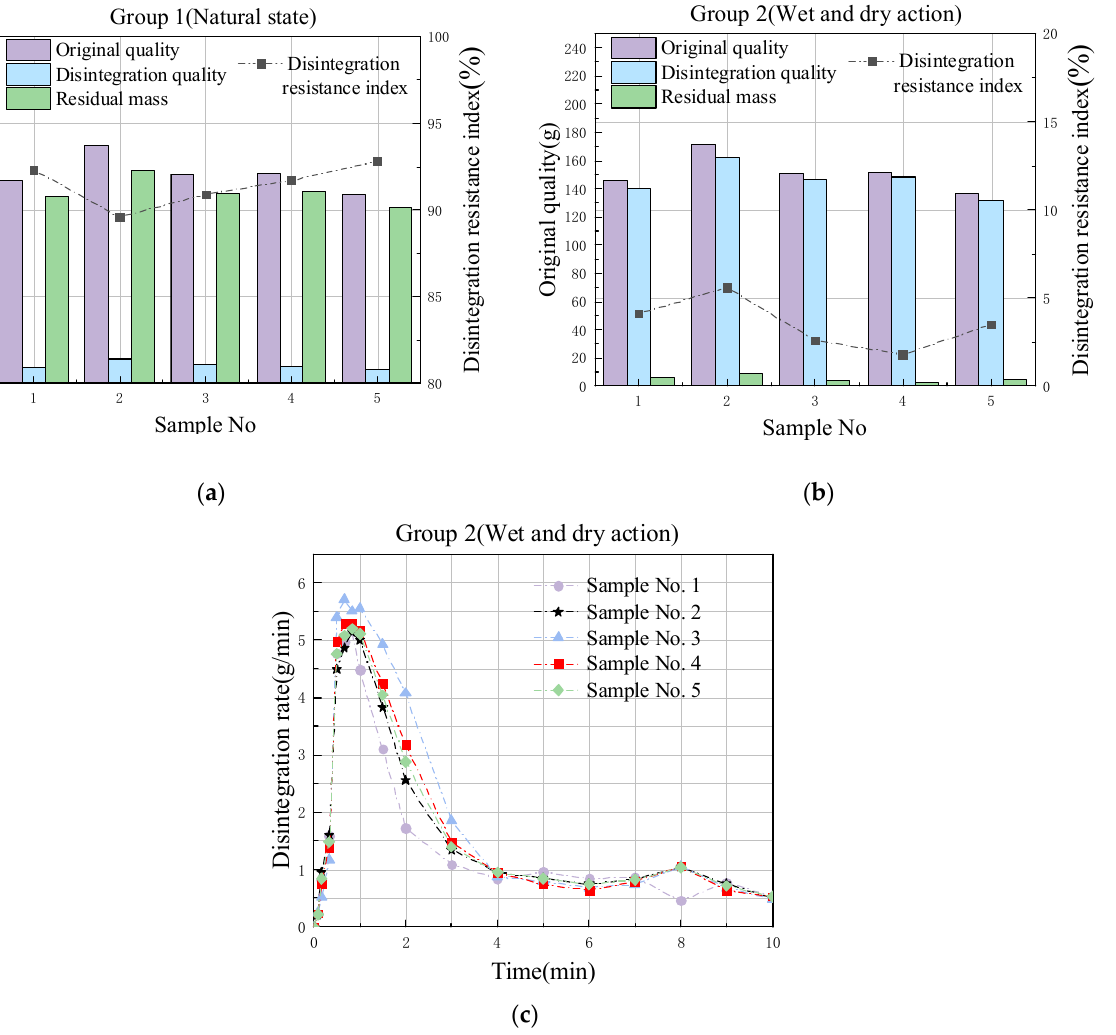
Figure 4. Disintegration test results of the two sets of samples: ( a ) comparison chart showing the disintegration resistance index values of the first group of samples; ( b ) comparison chart showing the disintegration resistance index values of the second group of samples; ( c ) comparison chart showing the disintegration rates of the first group of samples (average mass of 151.22 g).